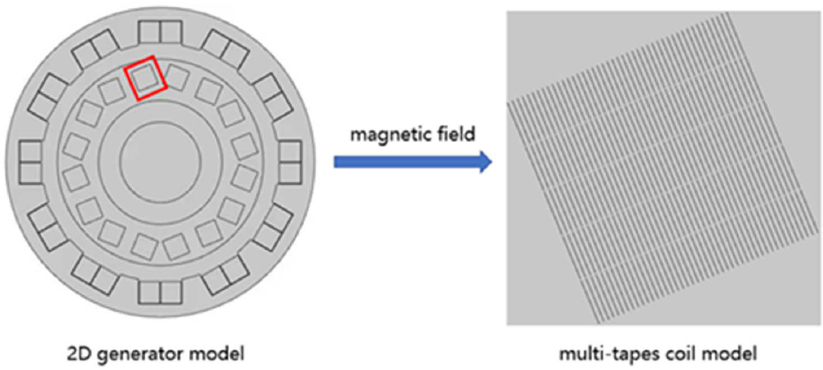
Figure 7. The generator model’s magnetic field is sampled and injected into the coil model.